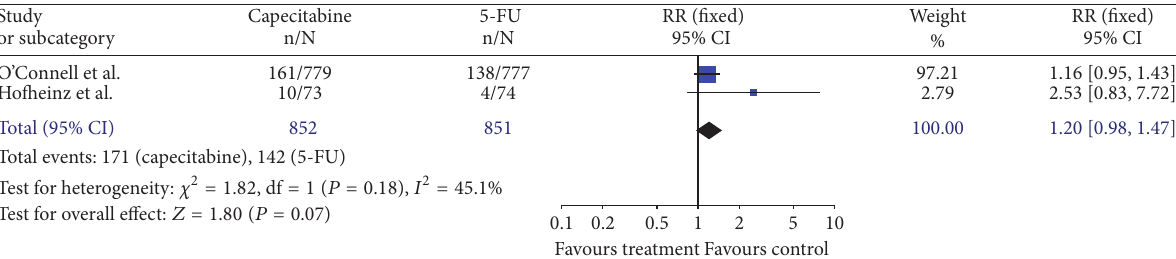
Figure 3: Forest plot of relative risk (RR) for pCR rate of RCTs only.